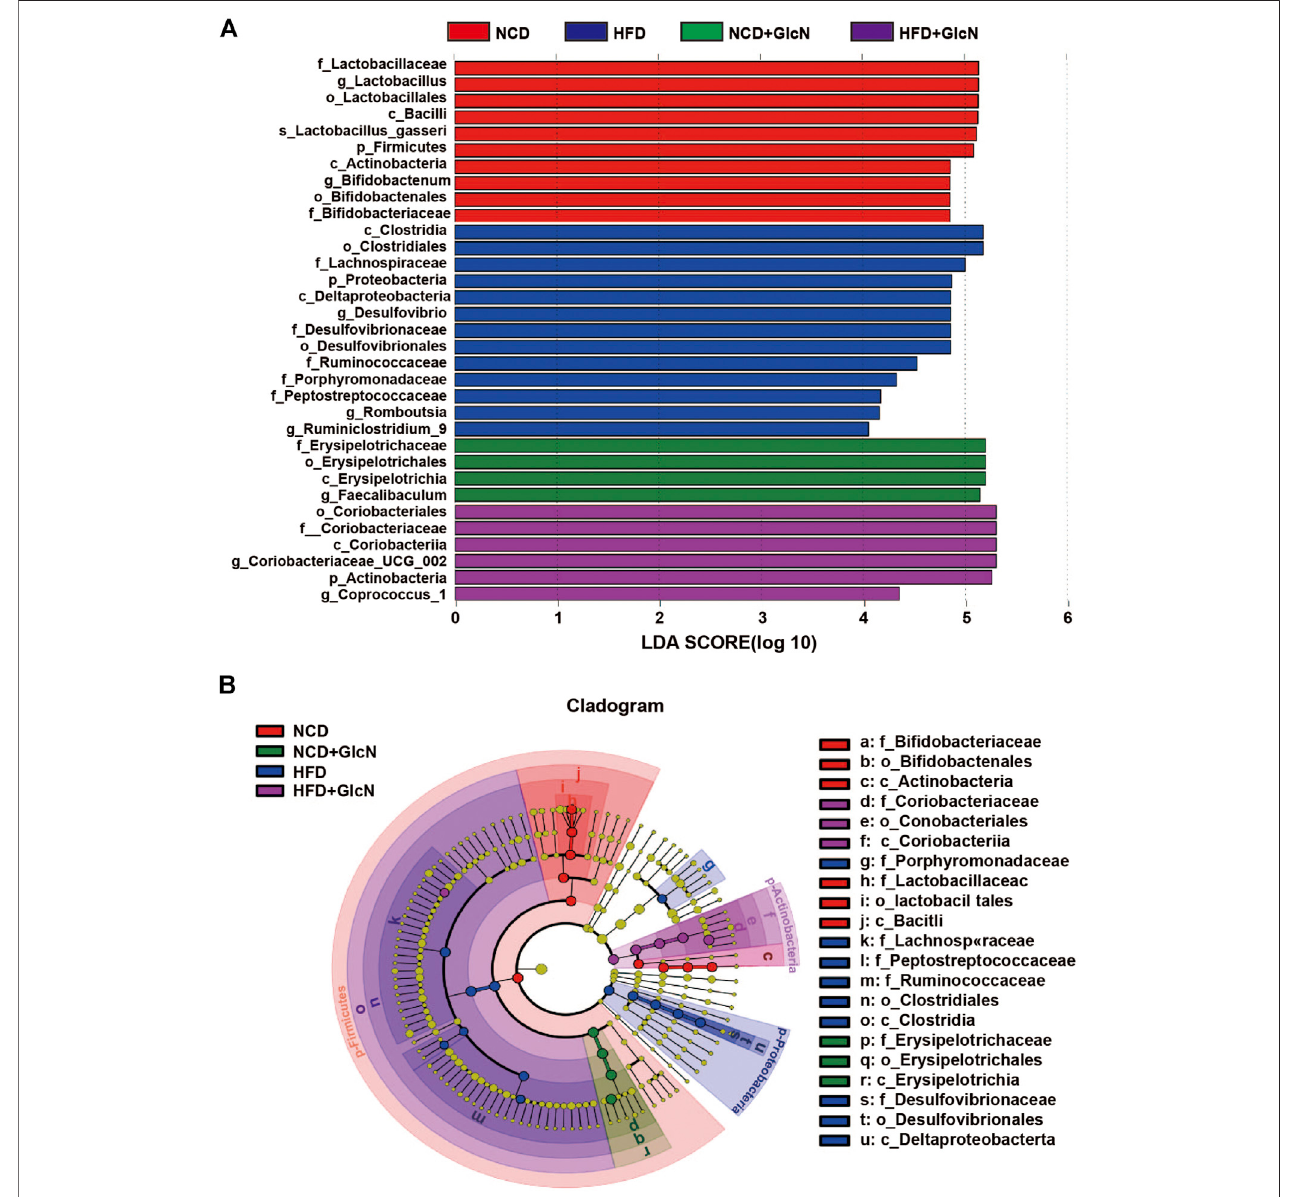
FIGURE 5 | Identi fi cation of most signi fi cantly contributed intestinal microbes among experimental groups using Linear discriminant analysis (LDA) and Linear discriminantanalysisEffectSize(LEfSe).AfterthetreatmentwithNCD,HFD,and/orGlcN(1 mg/ml,indrinkingwater)for5 months,allmiceweresacri fi cedandthececal contentswerecollectedfor16SrDNA sequencing. LEfSe analysiswasperformedbasedontheintestinalmicrobialabundancesand compositions,andtheresults were displayed in the form of LDA value distribution histogram (A) and cladogram (B) .